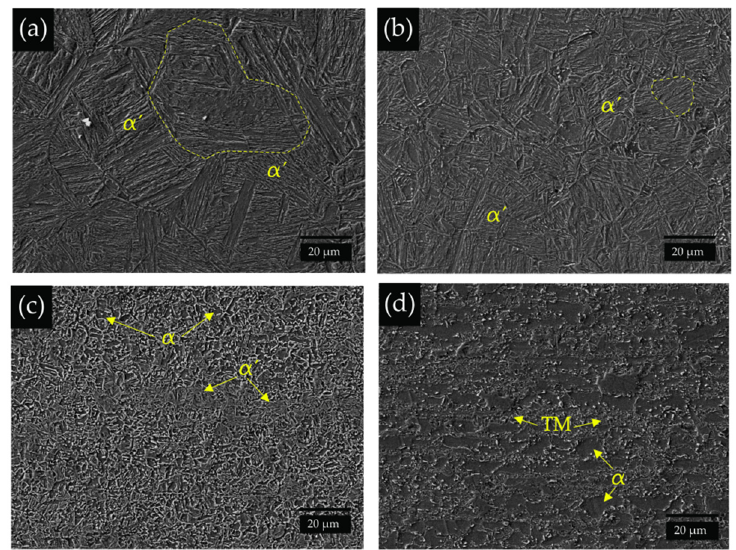
Figure 6. Microstructure development along the HAZ of the DP steel side: ( a ) UC-HAZ coarse grain,